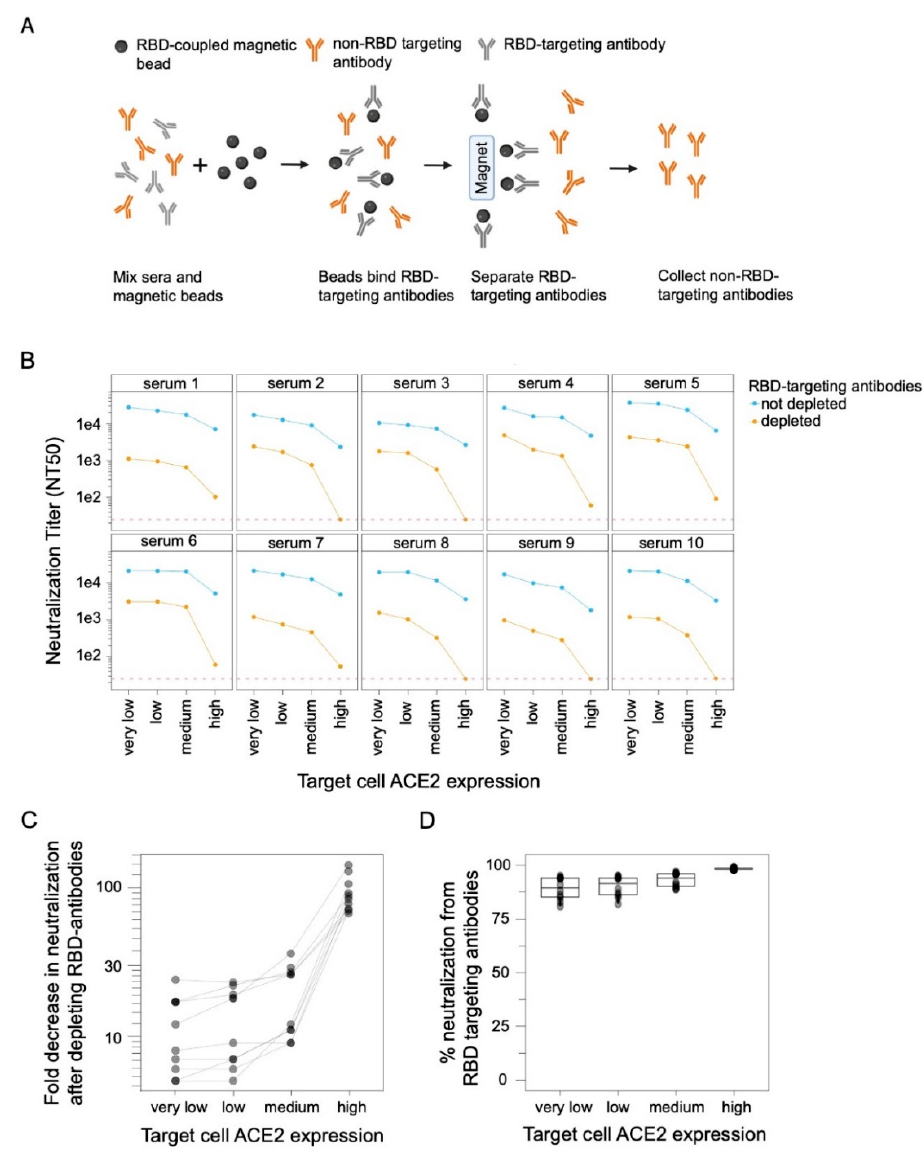
Figure 2. RBD-targeted antibodies make a larger contribution to serum neutralization when target cells express higher levels of ACE2. ( A ) Process for depleting RBD-targeted antibodies from poly- clonal human serum. RBD-coupled magnetic beads are incubated with sera. The RBD-targeting antibodies bind the beads and are then removed from sera by magnetic separation. RBD-targeting antibody depletion was confirmed by ELISA (Figure S2). This figure was created with BioRender.com. ( B ) Neutralization of D614G spike-pseudotyped lentiviral particles by polyclonal human sera from ten different individuals with or without depletion of RBD-targeting antibodies, as measured on target cells expressing different levels of ACE2. Neutralization is reported as the neutralization titer 50% (NT 50 ), which is the reciprocal serum dilution that neutralizes half of the virus. The dashed red line represents the limit of detection (NT 50 of 25), and values less than this limit are assigned a value of 25. ( C ) Fold decrease in neutralization after depleting the RBD antibodies and ( D ) percent of neutralization due to RBD-targeting antibodies for the sera shown in panel ( B ), calculated by subtracting NT 50 values for depleted sera from non-depleted sera and expressed as percentage of non-depleted sera